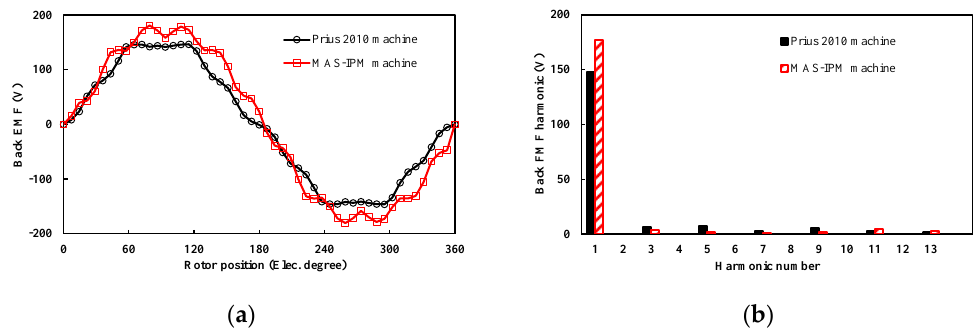
Figure 7. No-load back-EMFs of the two investigated machines (3000 rpm). ( a ) Waveforms. ( b ) Harmonic spectra.